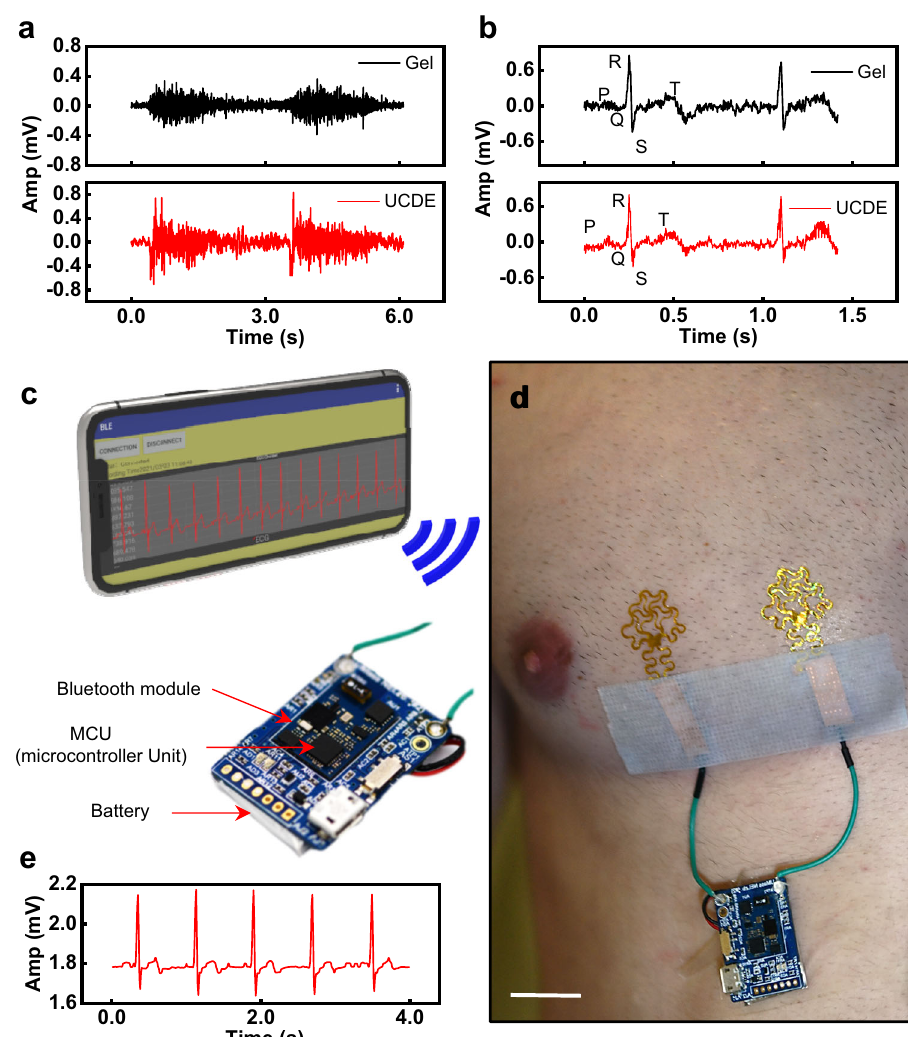
Fig. 2 Application of UCDEs as stretchable biopotential sensors. a EMG signal of commercial gel electrodes compared to UCDEs. b ECG signal of commercial gel electrodes compared to UCDEs. c – e Fully wireless ECG sensor. c Schematic illustration of wearable ECG device; a smartphone wirelessly connected via Bluetooth (top) to a controller unit (bottom). d Photograph of the stretchable UCDEs as ECG sensors integrated with the wireless operating system (scale bar, 4 cm). e ECG signal is recorded via the smartphone